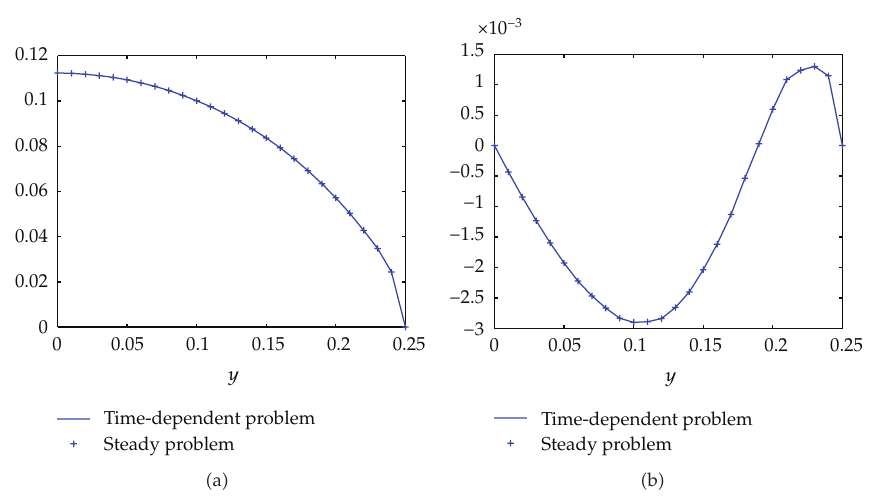
Figure 3: Horizontal (cid:2) a (cid:3) and vertical (cid:2) b (cid:3) velocity near reentrant corner. The marks “ (cid:11) ” indicate results for steady problem and “–” indicate results for the time-dependent problem at time t (cid:9) 24 . 5 using time step k (cid:9) 0 . 1.